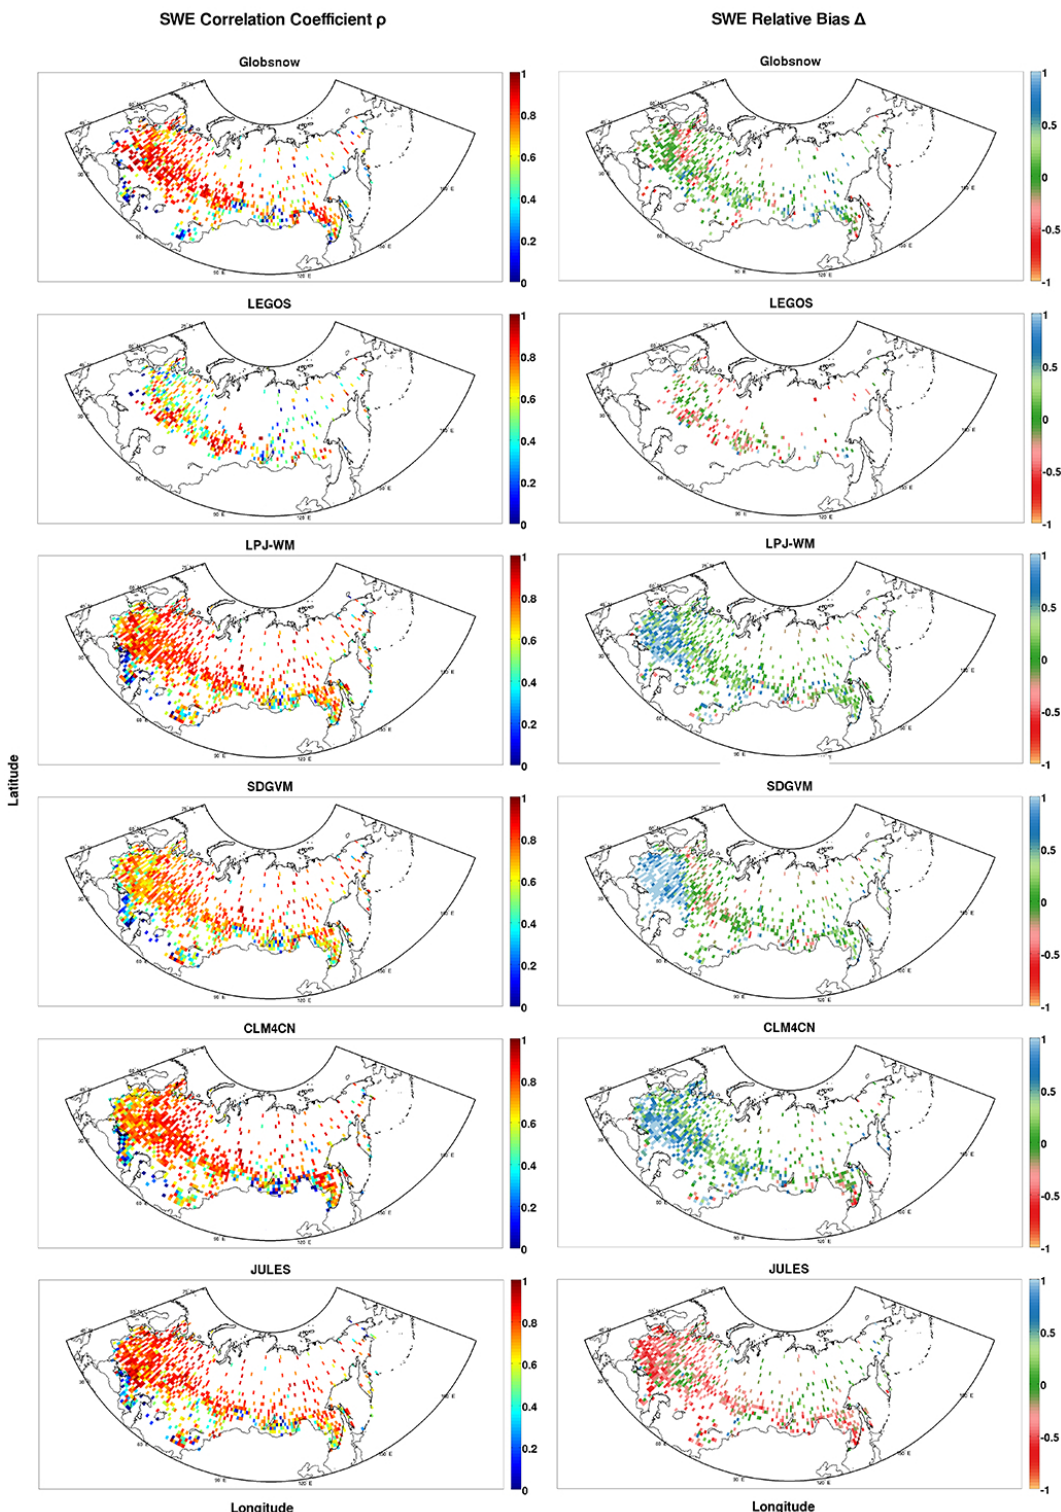
Fig. 2. (left) Correlation coefficient of monthly SWE, ρ , between the transect record and the six data sets across the extent of the FSU. (right) Relative bias, 1 , between the transect records and the data sets for grid cells with ρ ≥ 0.6.